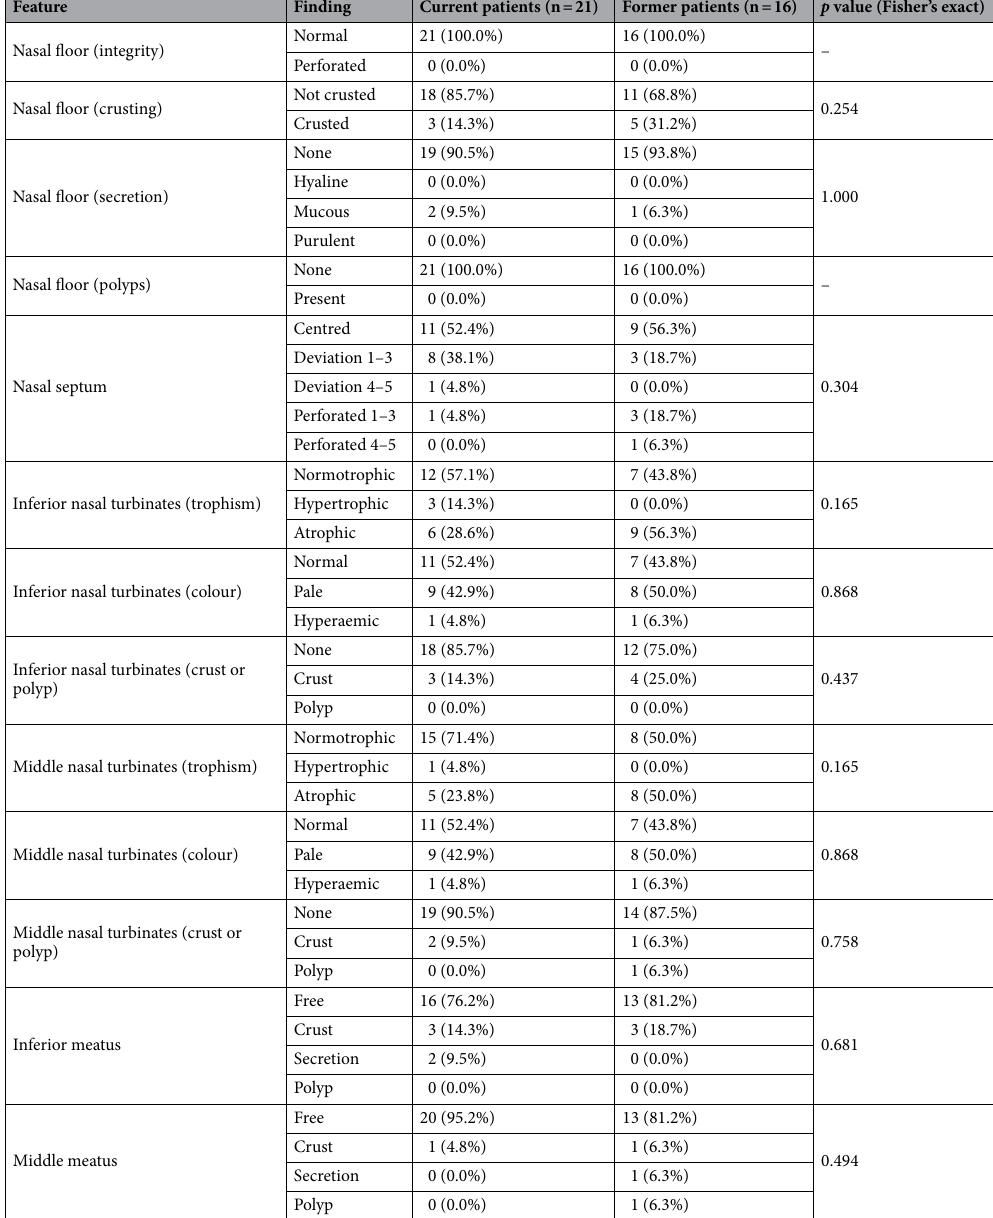
Table 2. Rhinoscopy and nasal endoscopy findings in current and former Hansen’s disease